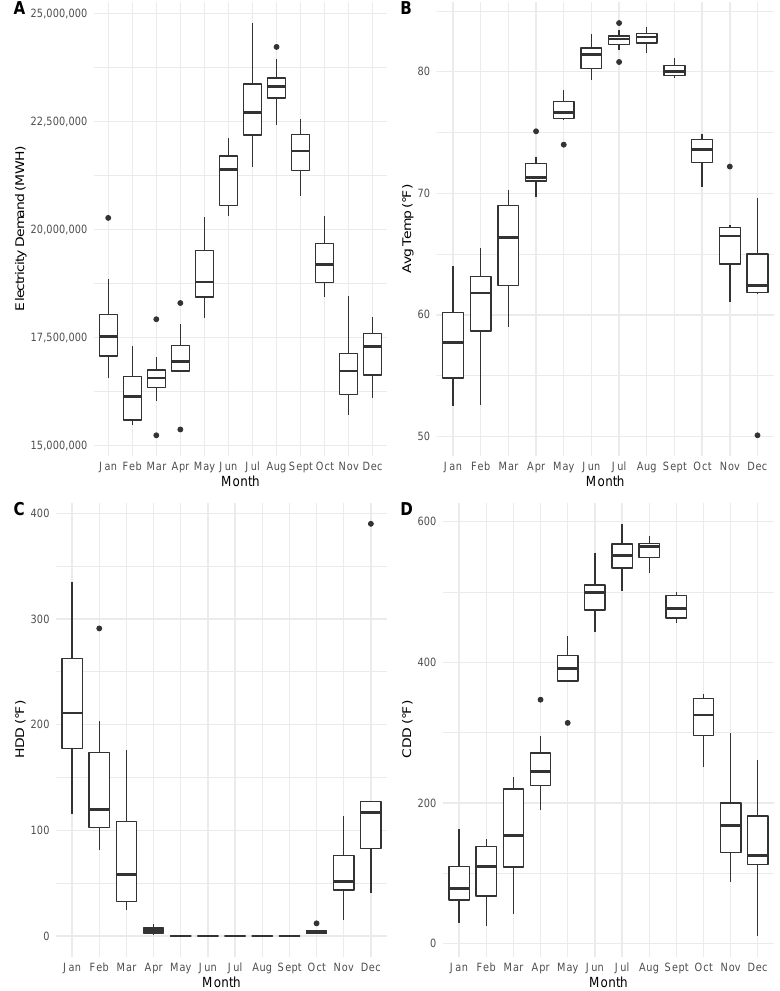
Figure 2. Box Plots of Electricity Demand ( A ), Average Temperature ( B ), HDD ( C ) and CDD ( D ) over time by